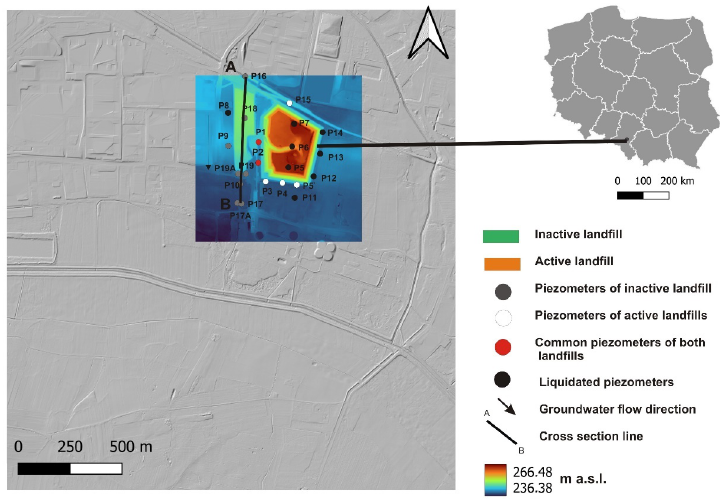
Figure 1. Location of the research area along with the observation network system.